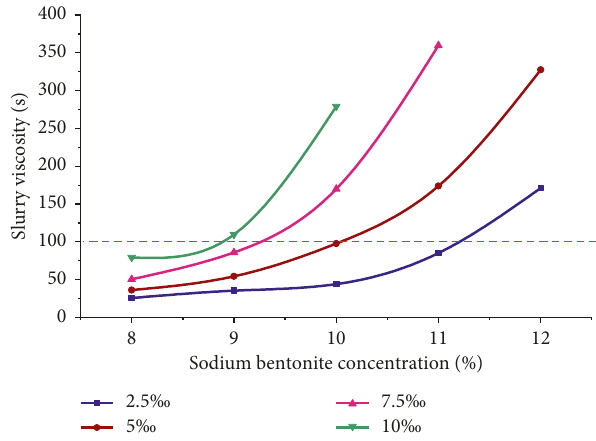
Figure 5: Viscosity curve of sodium-based bentonite-CMC mixed